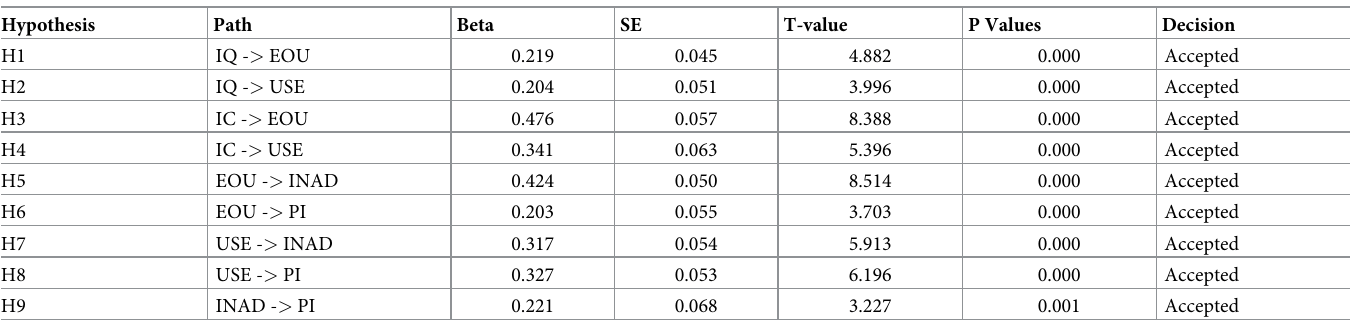
Table 4. Path coefficients.